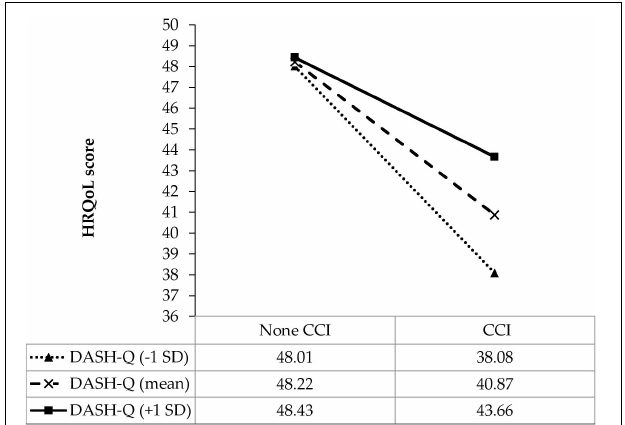
FIGURE 1 | Simple slope plot for the interaction between diet quality and comorbidity on HRQoL among patients with stroke ( n = 951). DASH-Q, diet quality; CCI, comorbidity; SD, standard